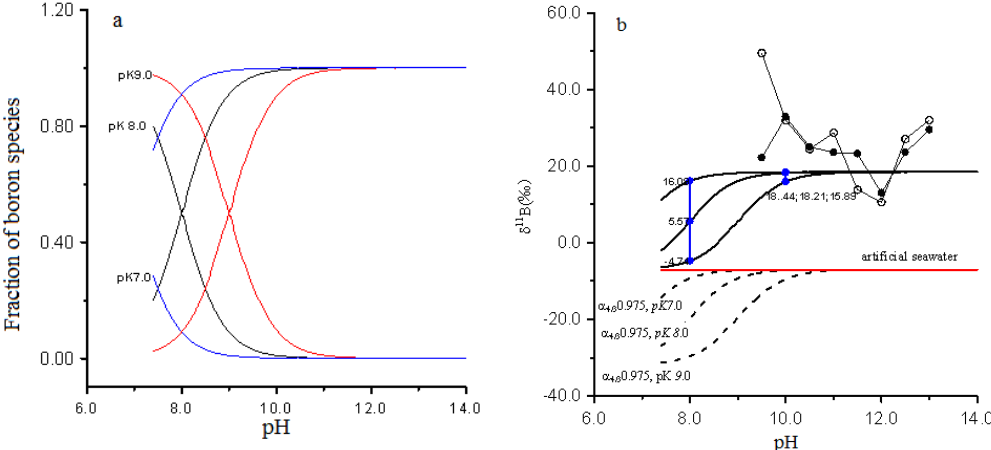
Fig. 6. The fraction (a) and δ 11 B (b) of boron species calculated using different pK a versus pH values. The influence of pK a on fraction and δ 11 B of boron species is big for a solution with the pH < 10. When the pH > 10, the influence of pK a is insignificant. For example, the δ 11 B isw3 calculated using pK a 7.0, 8.0 and 9.0 ( α 4 / 3 =0.975) are 16.08‰, 5.57‰ and − 4.74‰, respectively for pH 8 and 18.44‰, 18.21‰ and 15.89‰, respectively, for pH 10. When the pH > 11, there are basically no differences among them (Fig. 6b).